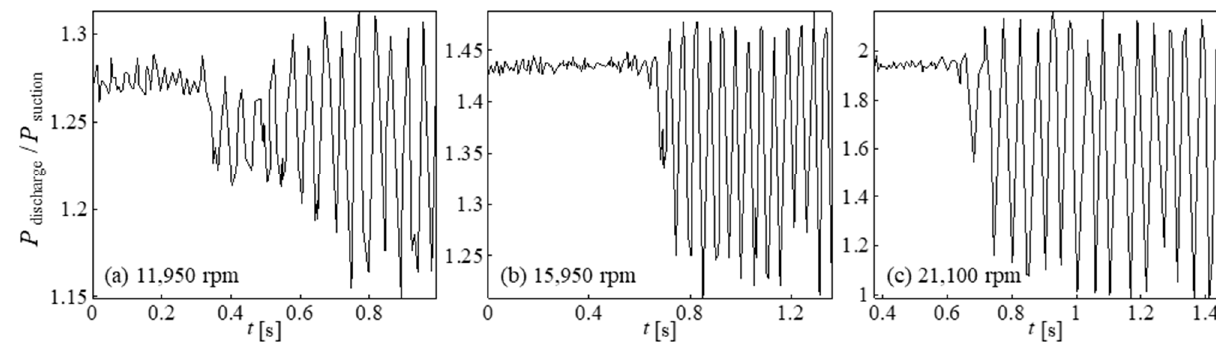
Figure 7. Surge initiation at ( a ) 11,950 rpm, ( b ) 15,950 rpm, and ( c ) 21,100 rpm.